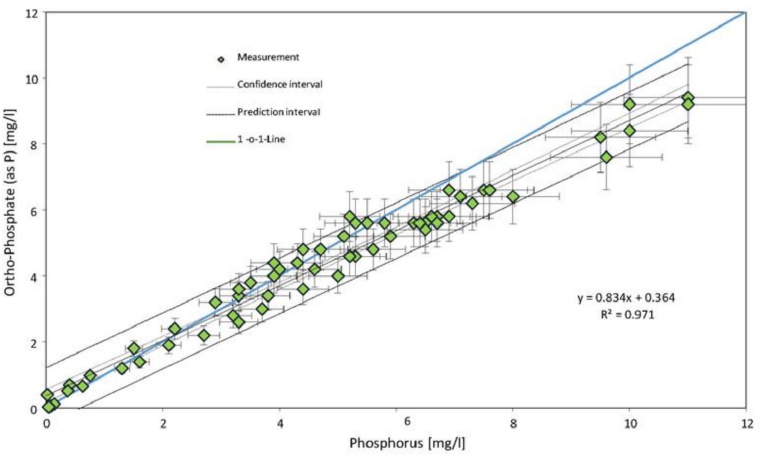
Figure 8. Relationship between ortho-phosphate (as P, measured by CFA) and total phosphorus (measured by ICP-MS) in sediment pore water samples in February 2019. The close relationship indicates that ortho-phosphate is the major phosphorus phase in sediment pore waters.